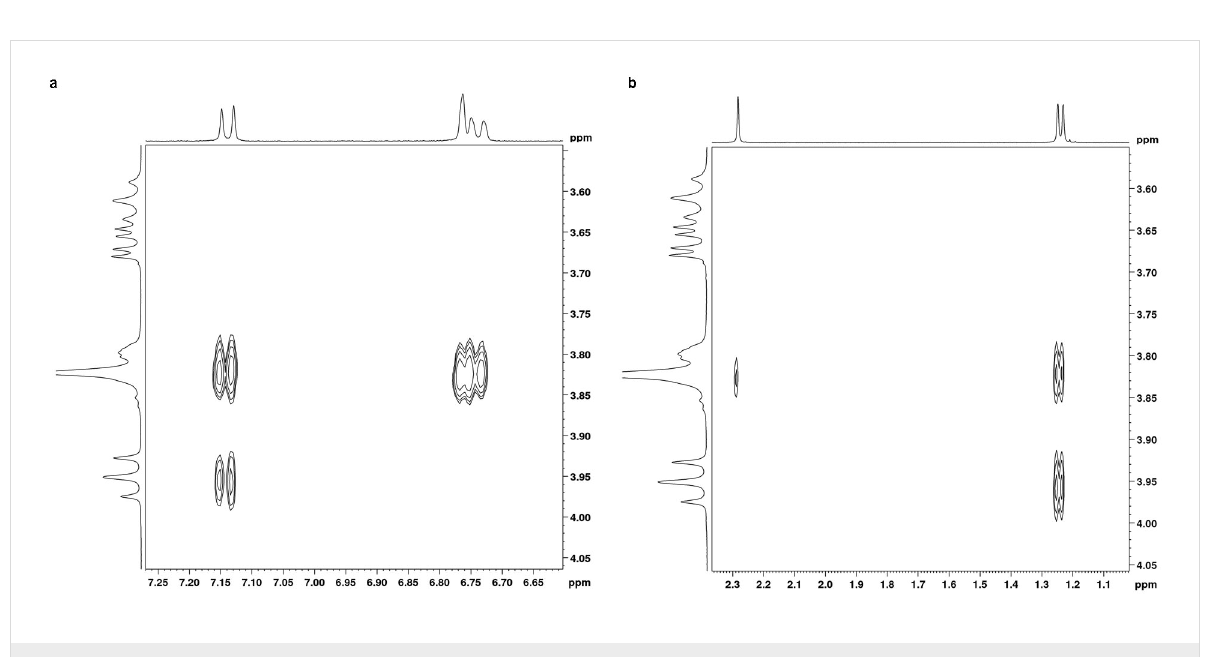
We can particularly see that H b and H c protons of 1 showed NOE cross peaks with both cavity protons while the H-a proton of 1 displayed NOE correlation peaks only with the H-5 proton of the CD cavity. Also, NOE cross peaks were observed between the H a and H c protons of 2 and both CD cavity protons but the H b proton of 2 exhibited NOE correlations only with the H-5 proton of the CD cavity. This indicated that the H a proton